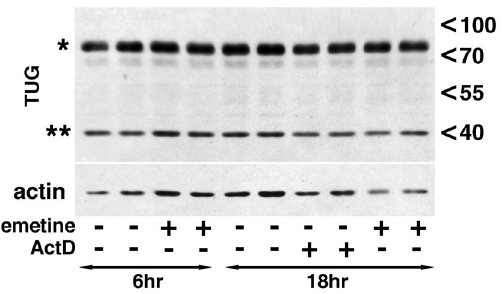
Figure 6. Actinomycin D and emetine do not affect proteolysis of TUG. Differentiated 3T3-L1 adipocytes were incubated in the absence and in the presence of emetine (20 µM) or ActD (5 µM) as indicated and the lysates from duplicate wells were analyzed by Western blotting. The asterisks mark the position of the full-length TUG (*) and its C-terminal proteolytic fragment (**). The positions of molecular weight markers are shown on the